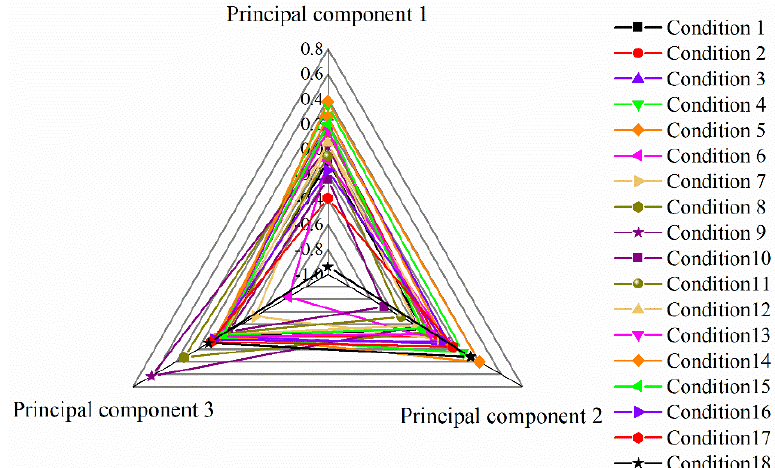
Figure 8. Analysis diagram of comprehensive evaluation.